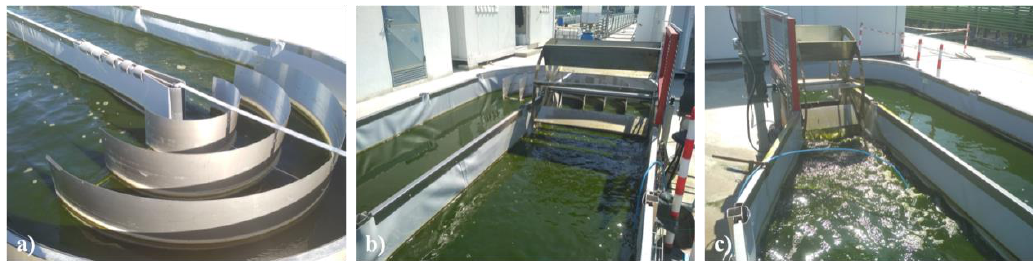
Figure 3. Structural details of the pilot raceways installed in Allmicroalgae facilities. ( a ) Three baffles in the circular endings of the ponds were installed in both standard and modified raceways. Single eight-flat-bladed paddlewheel was installed right after one of the semicircular ends of one of the channels; ( b ) standard raceway paddlewheel with 0.870 m width and ( c ) modified raceway with 0.475 m.